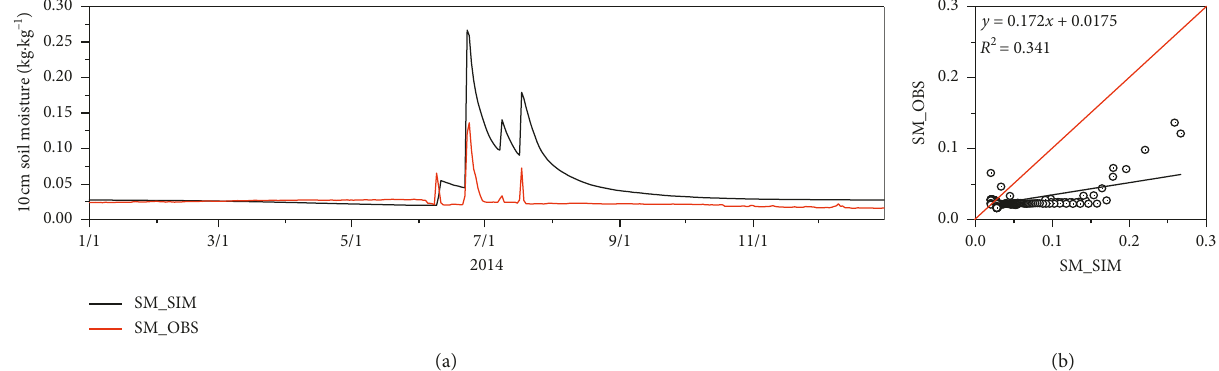
Figure 3: Contrast curve (a) and scatter plot (b) of the simulated (black) and observed (red) soil moisture (SM) for soil at a depth of 10cm at the Tazhong station in